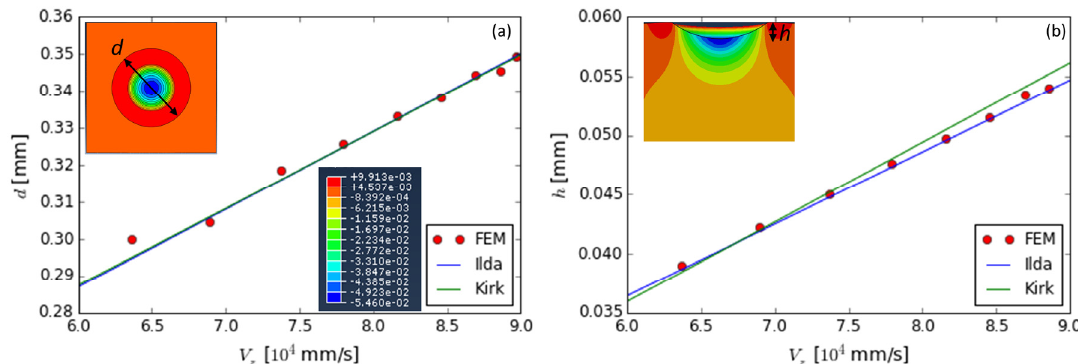
Figure 1. Comparison of the indent size diameter and depth estimated by the emperical equations of Kirk and Iida with the data obtained from the single impact finite element model (FEM) analysis (vertical impact, shot diameter: 0.6 mm, shot density: 7800 kg m − 3 , Brinell hardness: 201 HB); the inserts are representative vertical displacement contours; the stress range corresponds to both inserts.